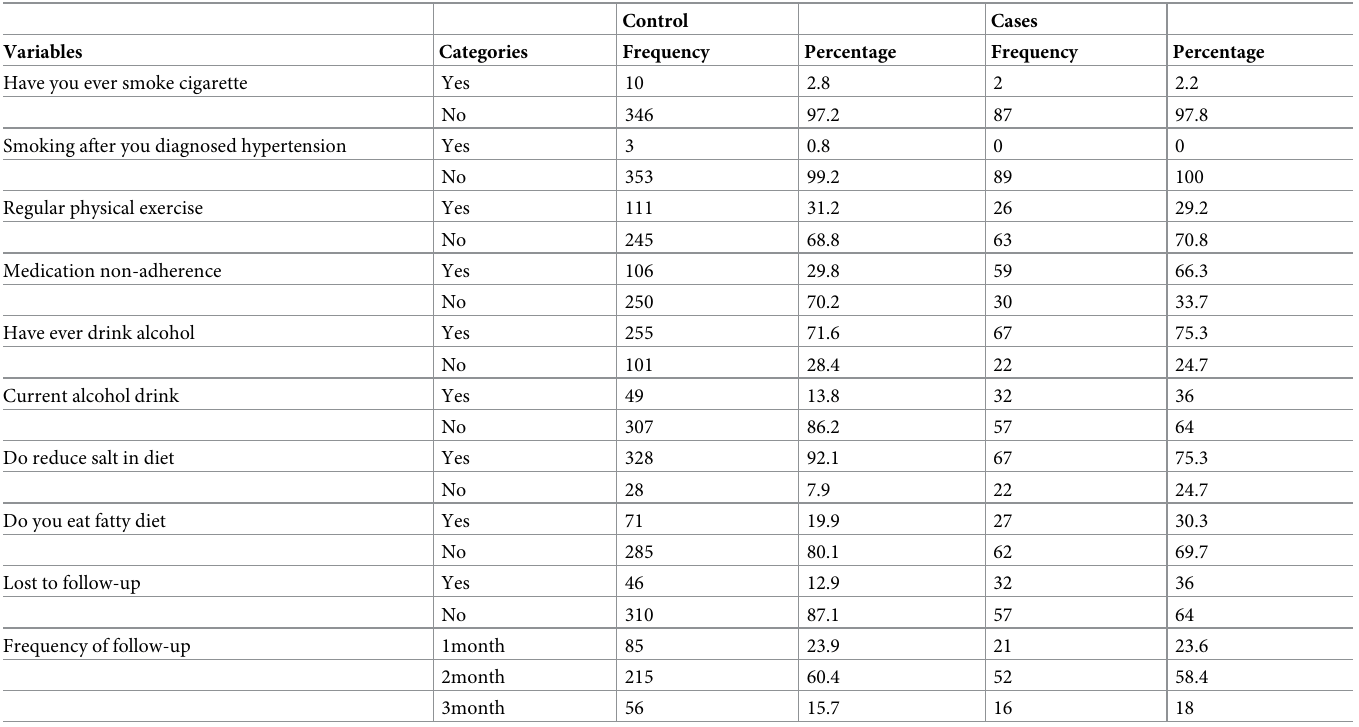
Table 2. Behavioral factors results of the participants.